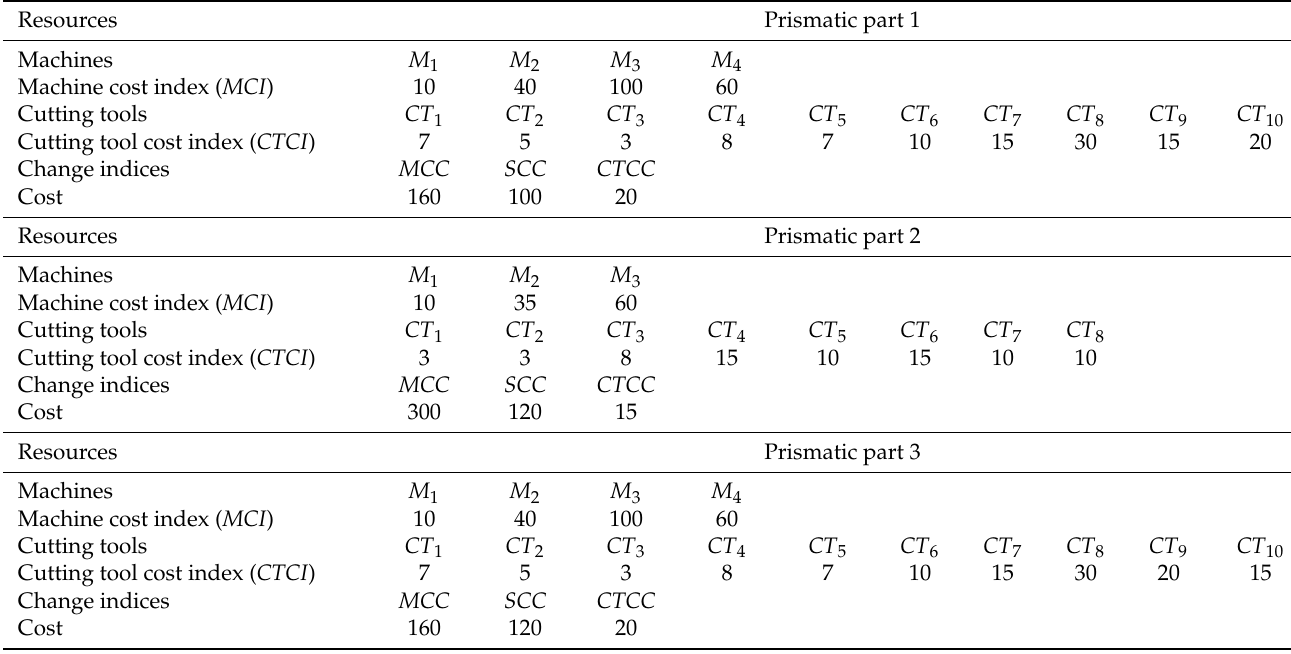
Table 7. Cost information for the considered prismatic parts.